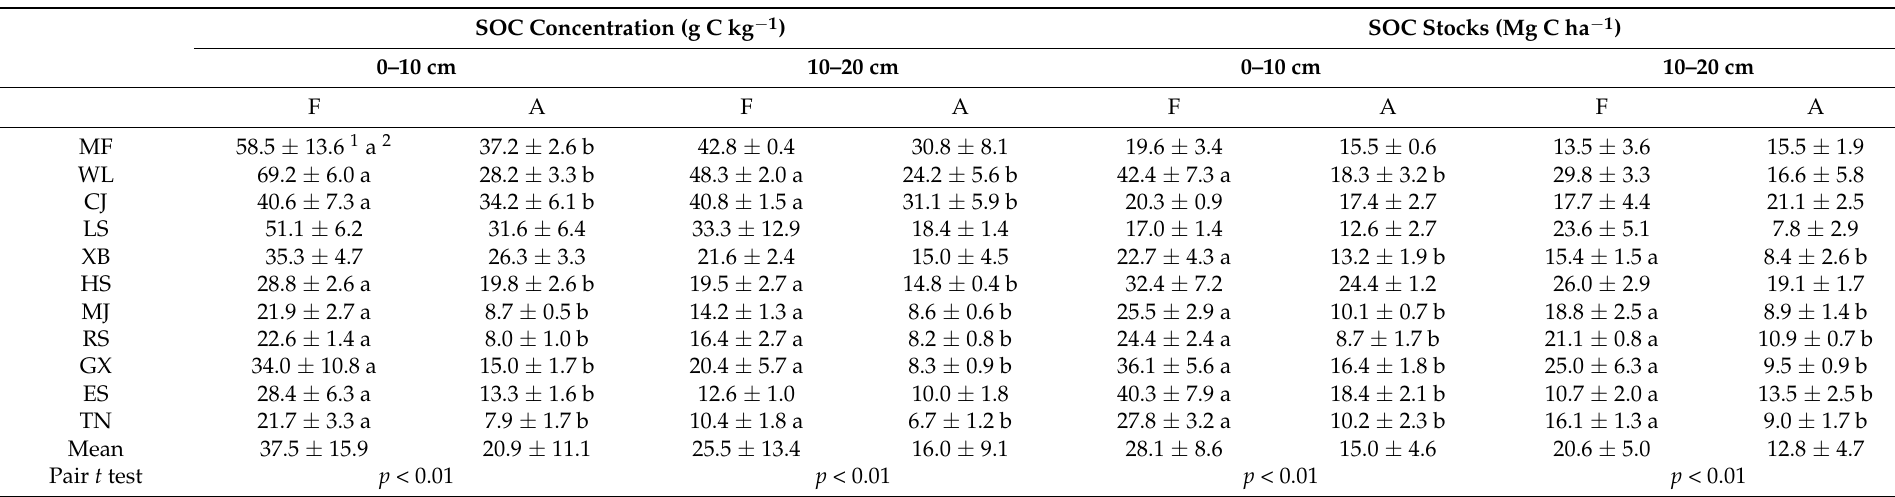
Table 2. Soil organic carbon (SOC) concentrations and stocks in forest regenerated (F) and adjacent agricultural (A) fields at 0–10 cm (surface) and 10–20 cm (subsurface) in Taiwan.